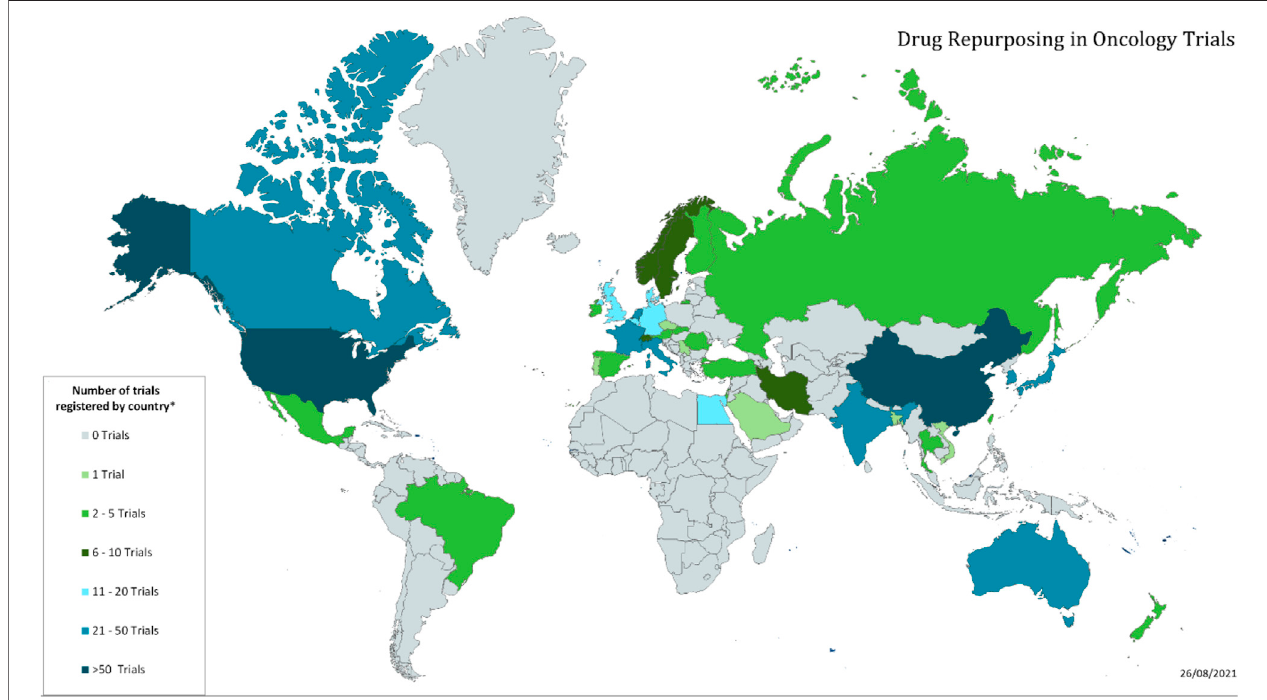
FIGURE 3 | Global distribution of repurposing trials in